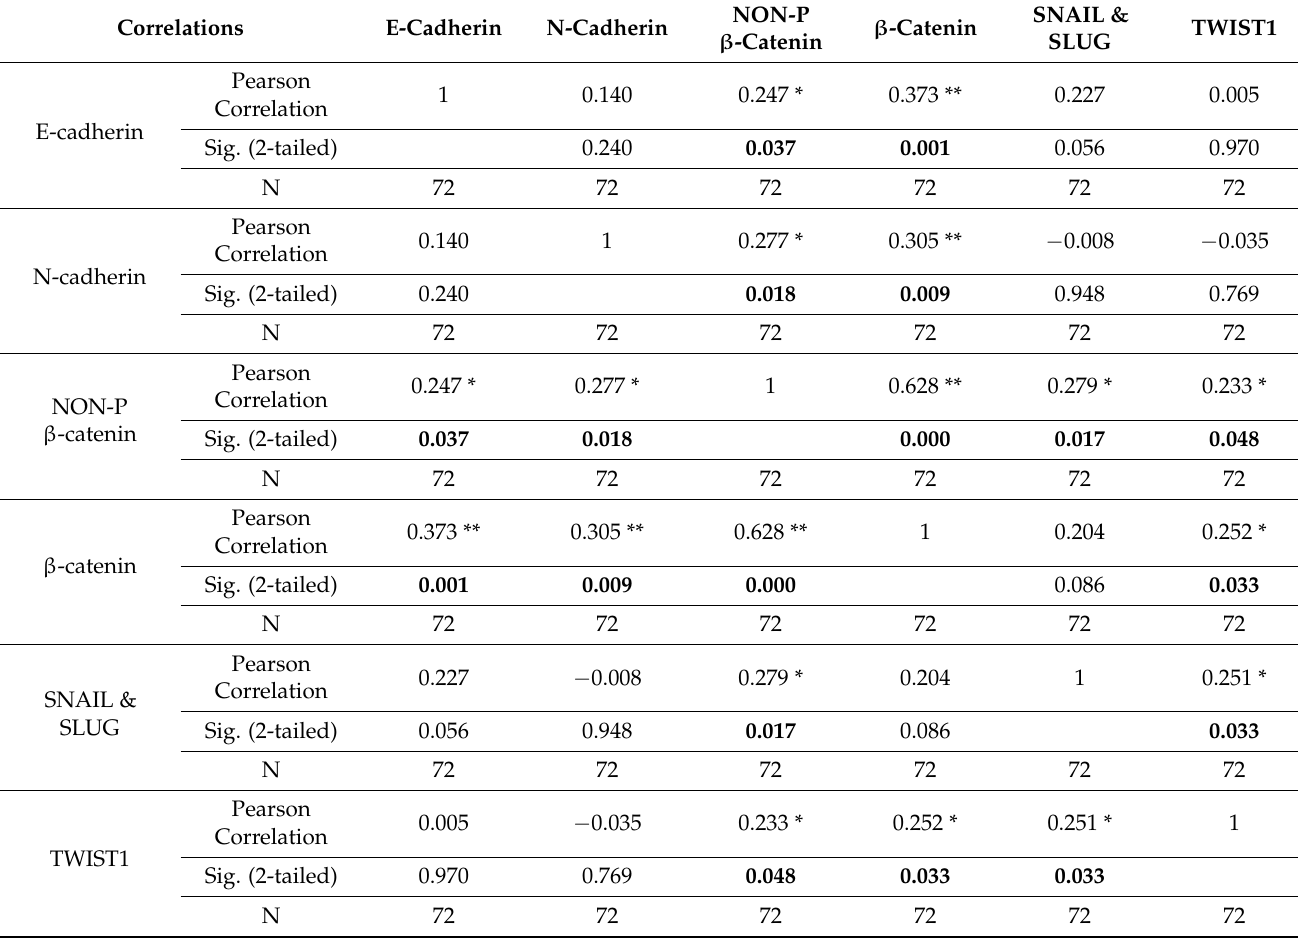
Table 2. Results of correlations between protein expressions of E-cadherin, N-cadherin, β -catenin, non-phosphorylated β -catenin (NON-P β -catenin), TWIST1 and SNAIL and SLUG. Pairs that showed a statistically significant association were: E-cadherin and β -catenin ( p = 0.001), E-cadherin and NON-P β -catenin ( p = 0.037), N-cadherin and β -catenin ( p = 0.009), N-cadherin and NON-P β -catenin ( p = 0.018), β -catenin and NON-P β -catenin ( p = 0.000), β -catenin and TWIST1 ( p = 0.033), NON-P β -catenin and SNAIL and SLUG ( p = 0.017), NON-P β -catenin and TWIST1 ( p = 0.048), and TWIST1 and SNAIL and SLUG ( p = 0.033). In all pairs, the correlation was